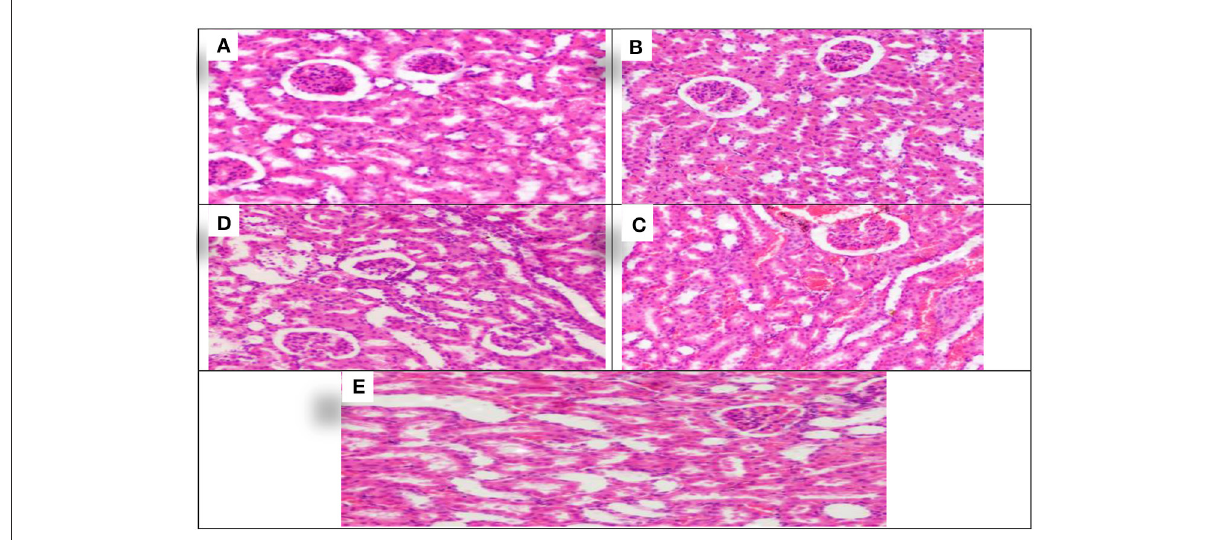
FIGURE3 Schematic diagram showing the effect of each aluminum, medicinal plant, and mix with aluminum and medicinal plants on histopathology of rats’ Kidney 60 days after treatment. (A) Control group. (B) 1,600 ppm Aluminum. (C) 1,600 ppm Aluminum + Allium sativum 5%. (D) 1,600 ppm